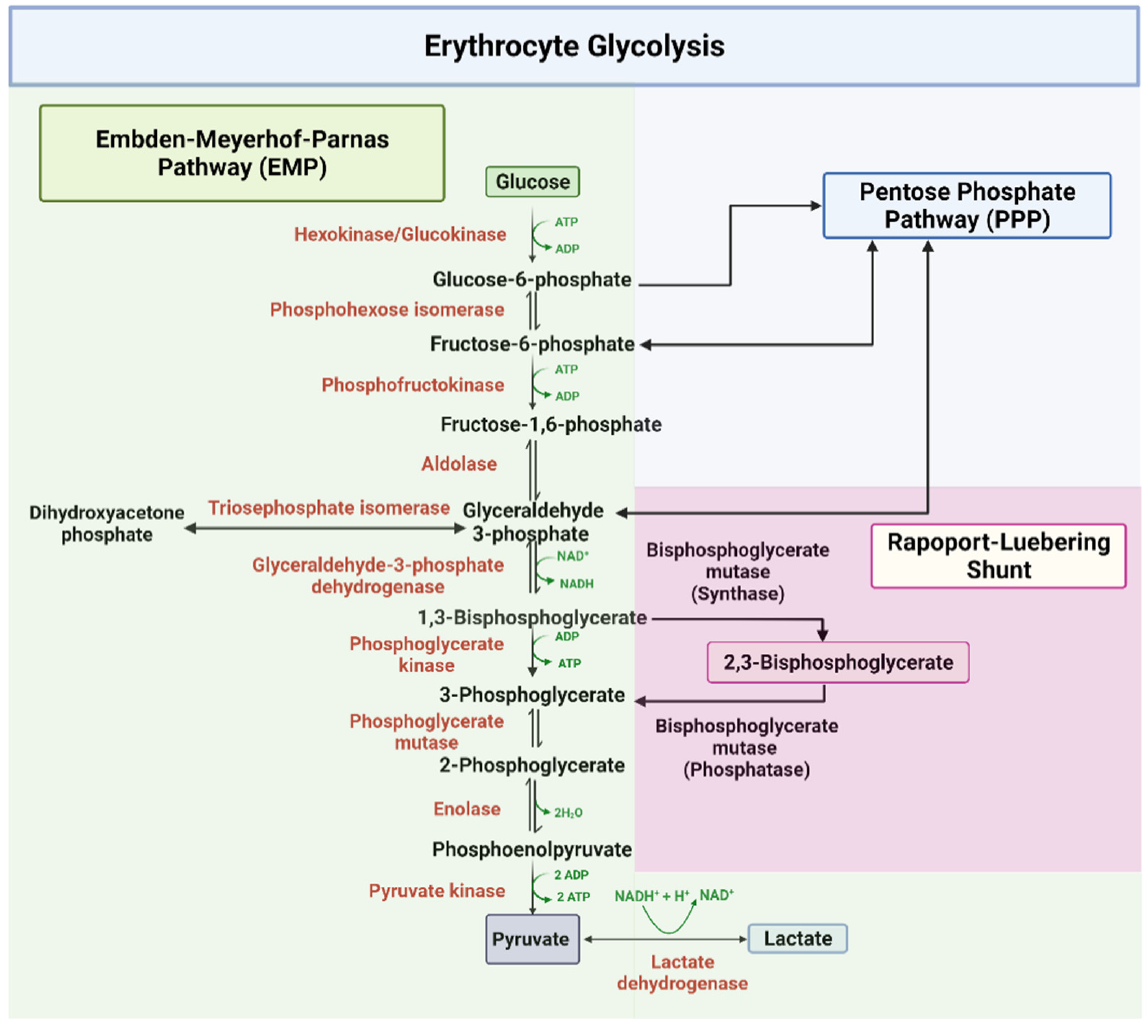
Figure 1. The glycolytic pathway [41–43,45].